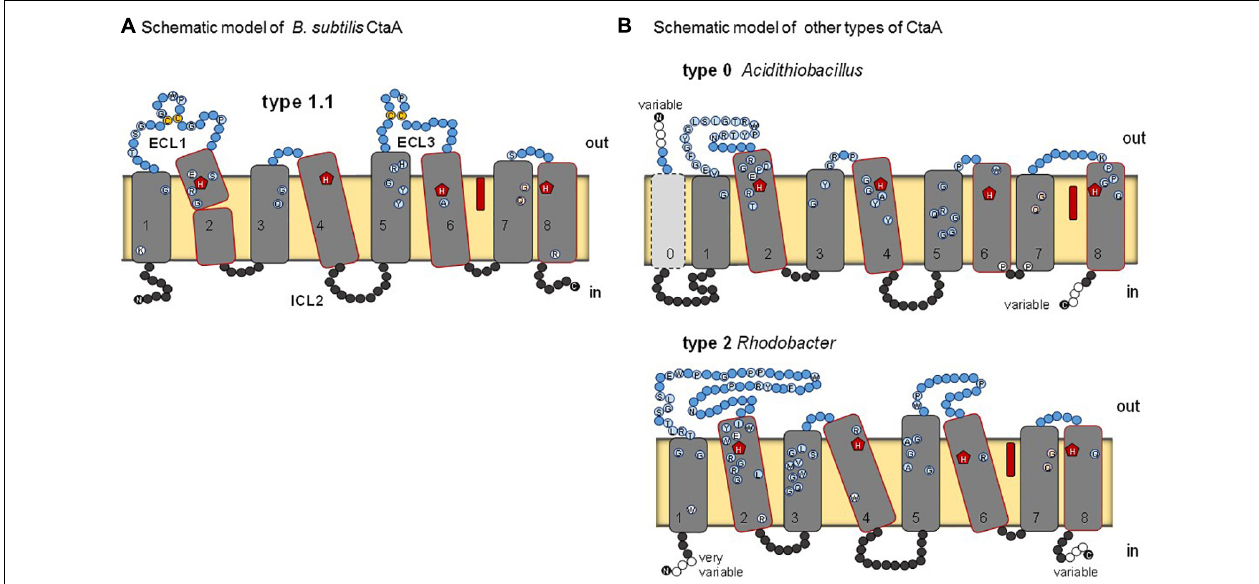
FIGURE 2 | Schematic models for various types of heme A synthase. (A) B. subtilis CtaA, based on the reported crystal structure of the protein (Niwa et al., 2018). Residues conserved among type 1.1 CtaA are shown by circles. ECL1 and ECL3 indicate extracellular loops on the periplasmic side (outer side) of the membrane. Heme B (red elongated symbol) occupies the cofactor domain. Disulfide linked cysteine residues in ECL1 and ECL3 are in yellow. (B) Models for type 0 and type 2 CtaA represented by the Acidithiobacillus ferrooxidans and Rhodobacter capsulatus enzymes, respectively. See Table 1 for the classification of CtaA proteins. Residues that are conserved in the sequences of the represented types are shown by circles as in Panel (A)